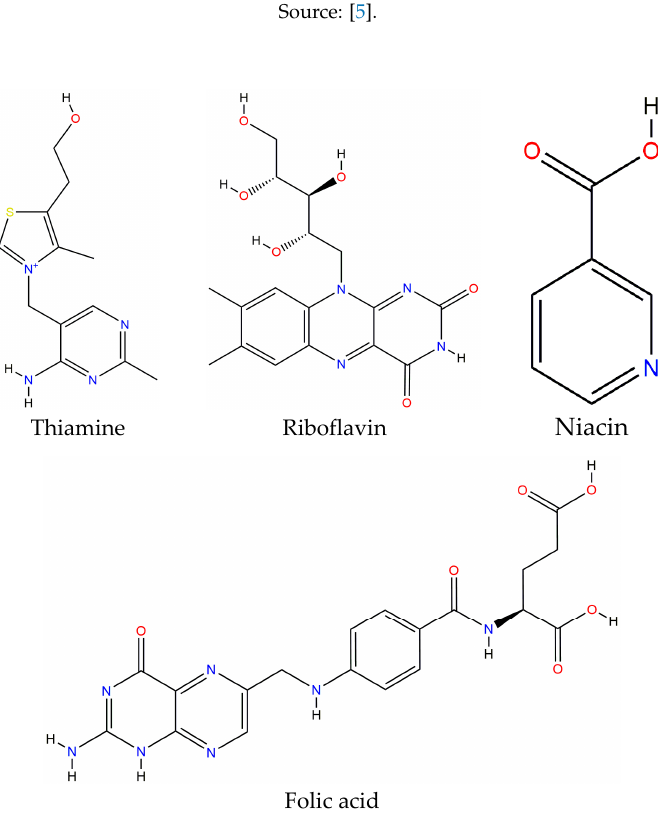
Figure 4. Structures of major vitamins of P. vulgaris [46].